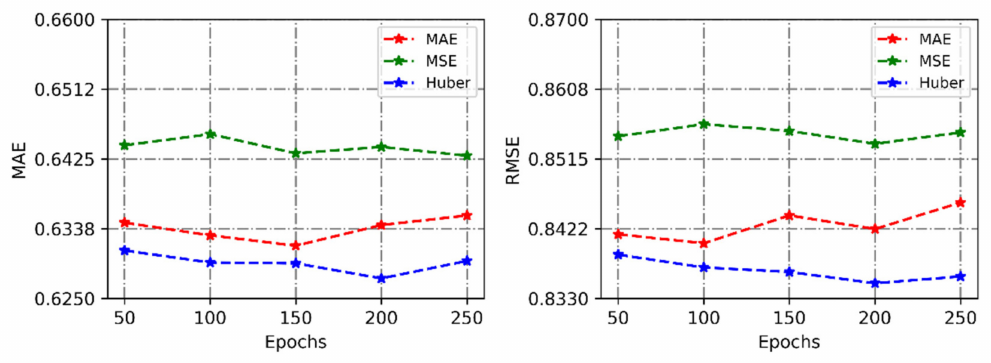
Figure 3. Comparison between loss